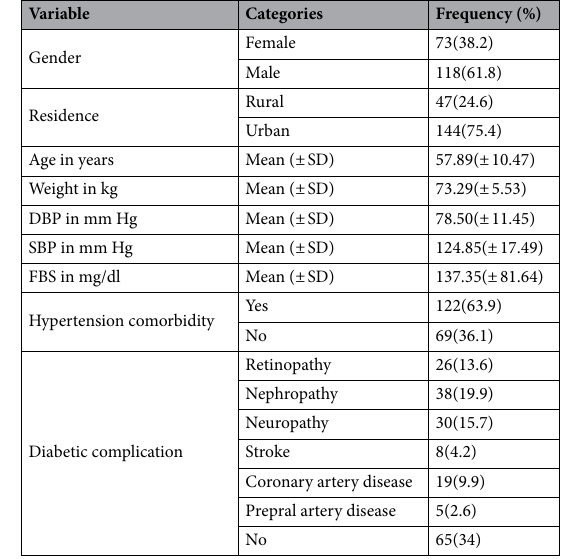
Table 1. Population characteristics for 191 type 2 DM patients with 1740 glycimic control stataus observations at Felege Hiwot and Debre Markos Referral Hospital, December 2014-January